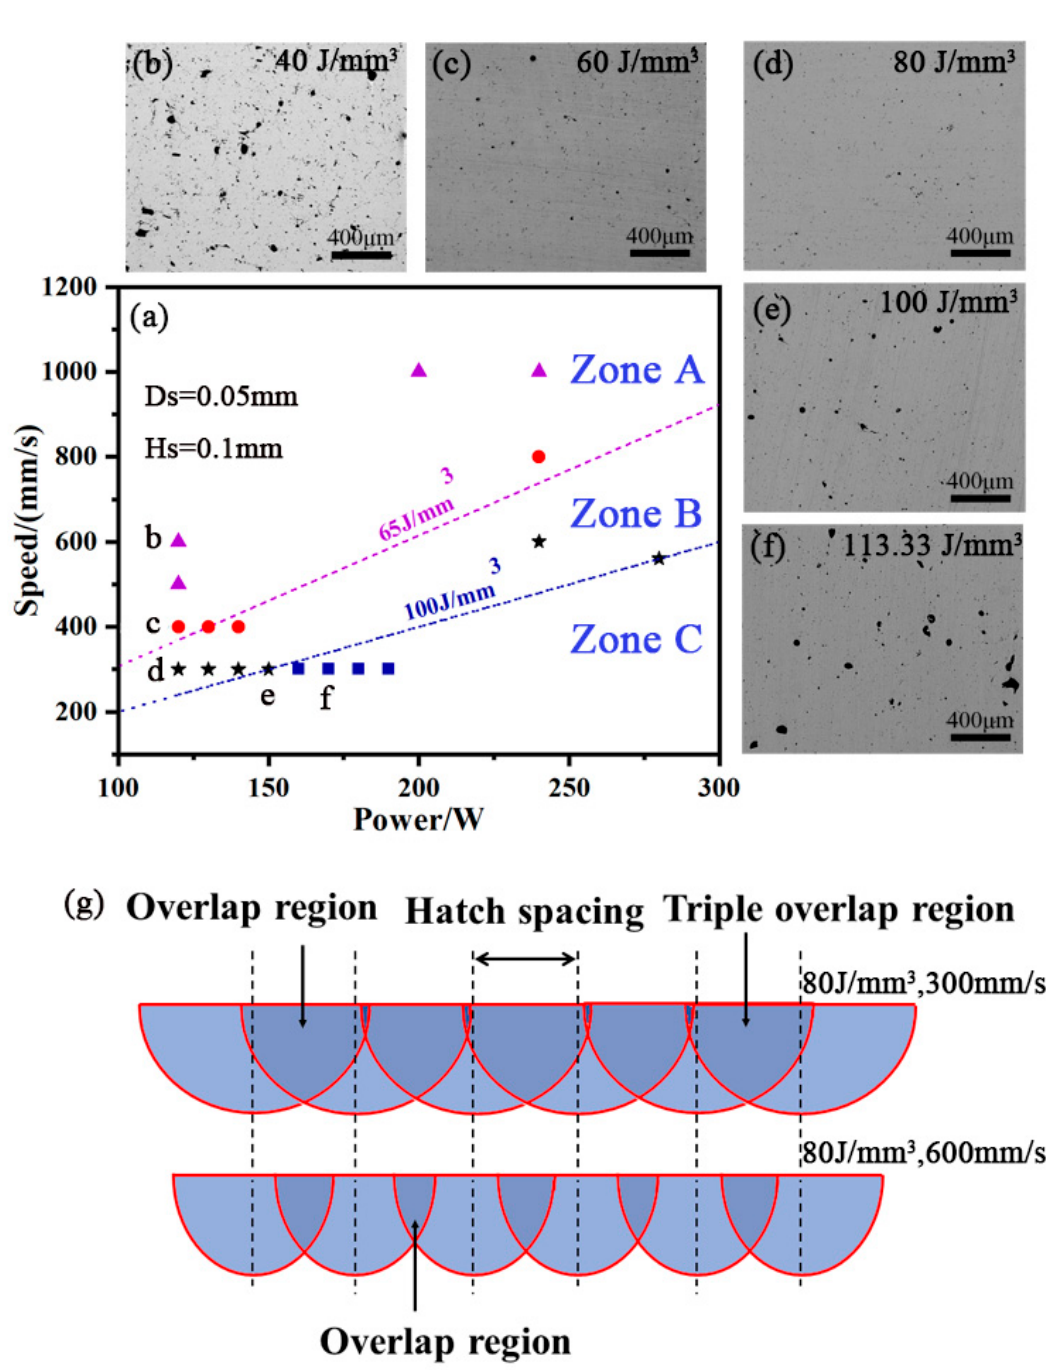
Figure 3. ( a ) Processing map of AS41 samples formed by SLM with different laser powers and scanning speeds, ( b – f ) microstructure of samples at different v E , ( g ) schematic illustration of the effect of the same v E with different scanning speeds on the molten pool